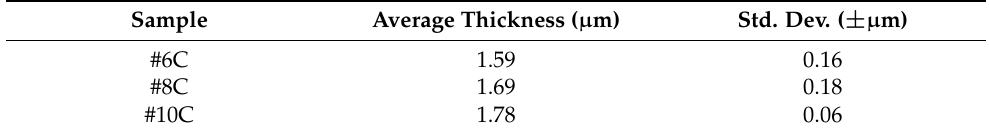
Table 5. XRF thickness determination of palladium coatings. The thicknesses of the palladium coatings derived from PDP+PCP procedure are reported in the second column.